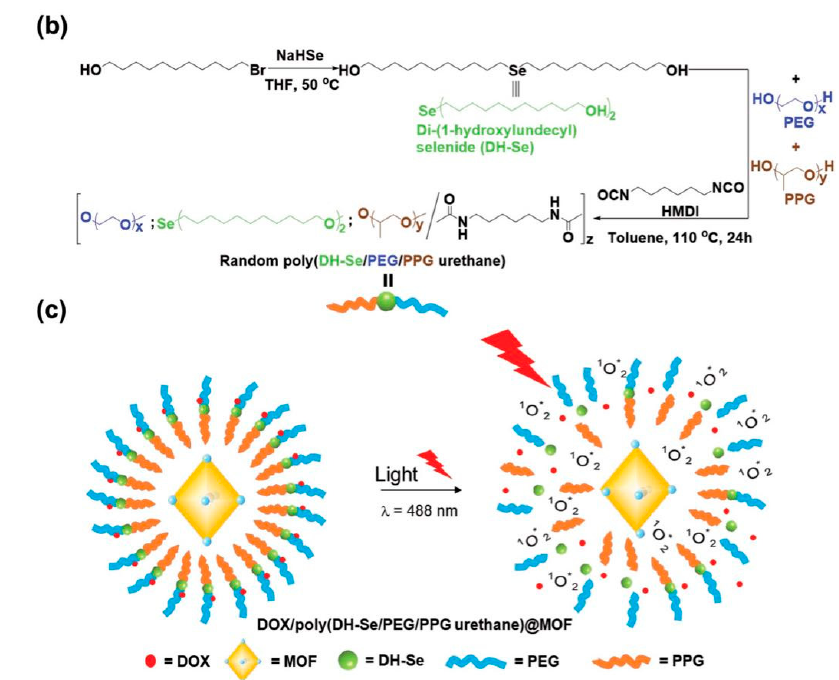
Figure 13. Schematic illustration of the synthesis of porphyrin PCN-224 MOF. ( a ) selenium containing random copolymer poly(DH-Se/PEG/PPG urethane) ( b ) and the design of proposed core/shell nanocomposite by using PCN-224 MOF and poly(DH-Se/PEG/PPG urethane) ( c ) whose structure could be broken with 488 nm light illumination and release the encapsulated anticancer drug DOX for precise chemotherapy. Reproduced with permission from Ref. [153] Copyright 2019, John Wiley & sons.